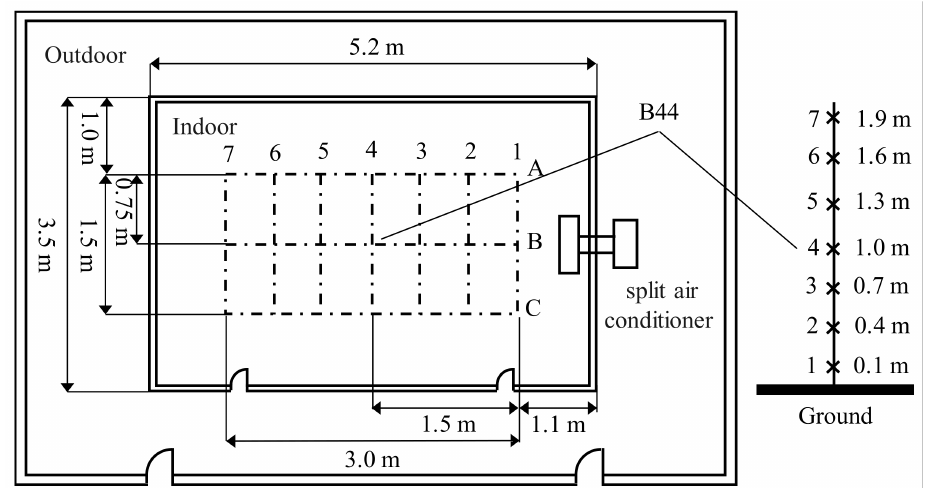
Figure 5. Schematic of an air-conditioned testing laboratory with a comfortable thermal environment.